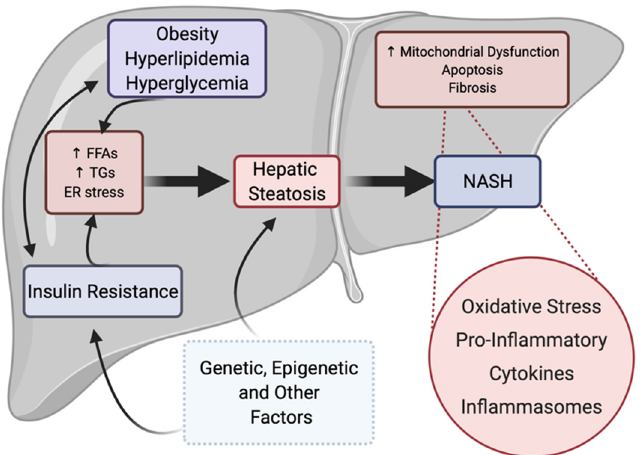
Figure 2. “Multi-hit” process of NAFLD progression. Insulin resistance, obesity, hyperlipidemia, and other factors may act independently or collaboratively to initiate the pathogenesis of fatty liver disease, characterized by increased hepatic triglyceride storage and steatosis. Disease progression may also be multifactorial, but most often occurs upon increased proinflammatory cytokine activation and increased hepatic oxidative stress, leading to NASH with fibrosis. Genetic, epigenetic, environmental, and other factors also play a role in the development of primary factors as well as in the development of steatosis. Figure created with BioRender.